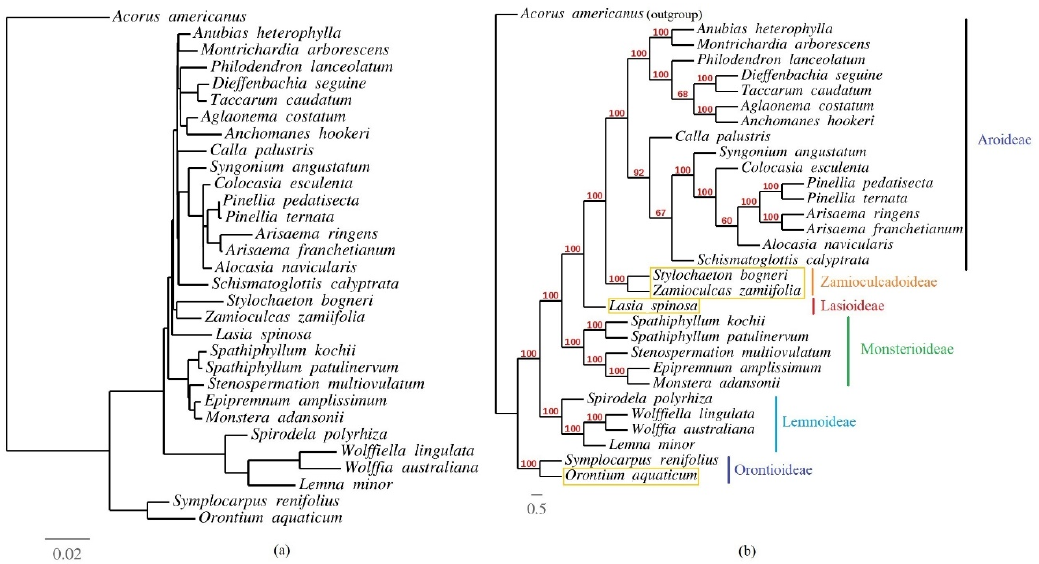
Figure 6. Maximum likelihood tree based on multiple alignment of 30 species of Araceae. ( a ) Phylogenetic tree; ( b ) cladogram. The bootstrapping support values are similar for the phylogenetic tree and the cladogram and are shown only on the cladogram for easy visualization. The four species reported in the current study are highlighted with yellow